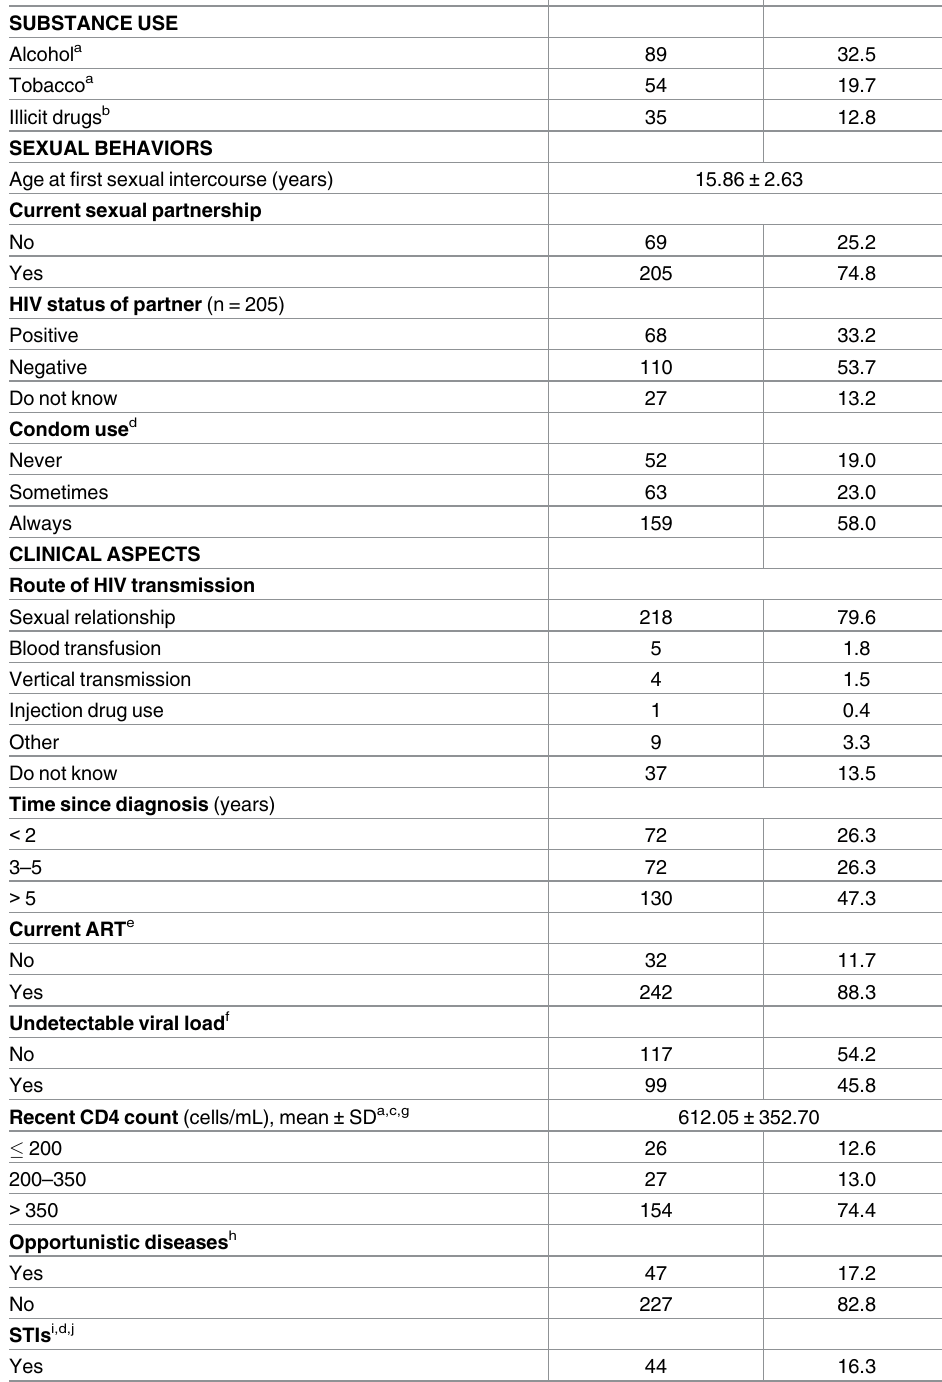
Table 2. Substance use, sexual behaviors, and clinical characteristics of WLWHA in Central Brazil,